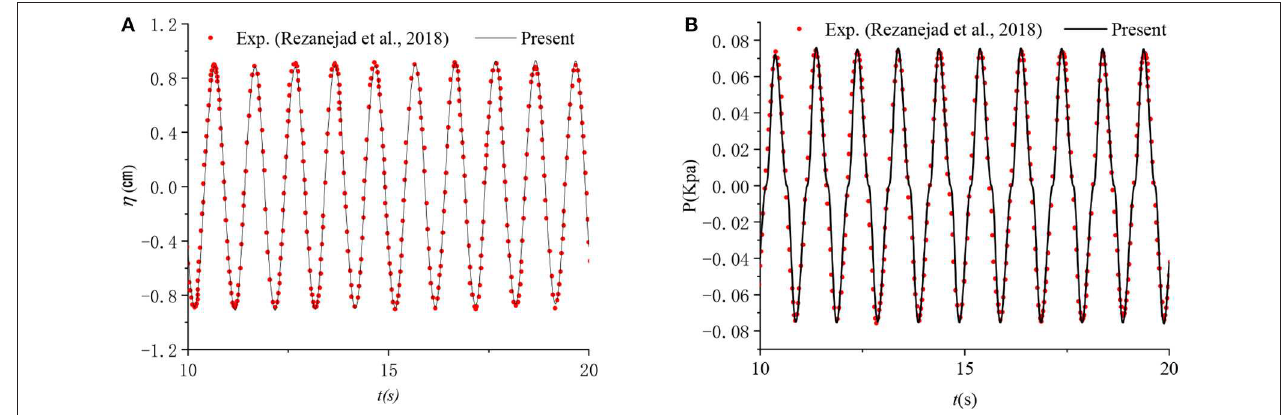
FIGURE 5 | Time series of free surface elevation at the center of the chamber and oscillatory air pressure in the chamber. (A) Surface elevation in the chamber. (B) Air pressure in the chamber.